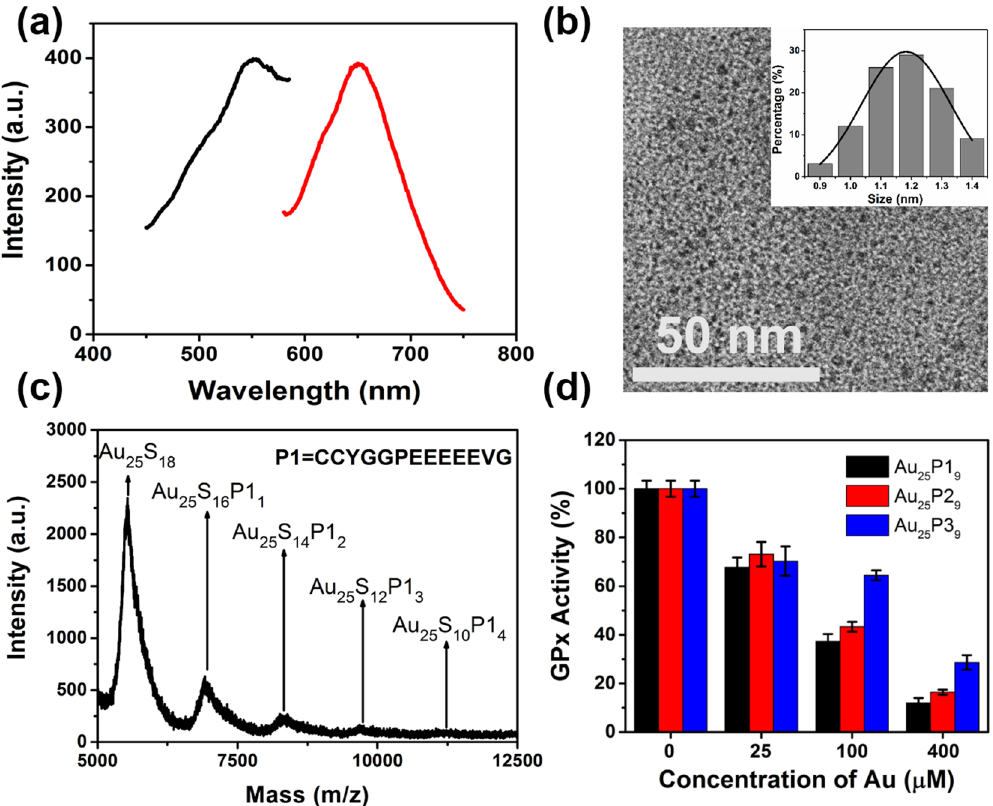
Figure 2. ( a ) Fluorescence excitation (black line) and emission (red line) spectra of Au 25 P1 9 . ( b ) HRTEM images of Au 25 P1 9 . Inset shows diameter distribution from statistic results of 100 particles. ( c ) MALDI-TOF MS spectra of Au 25 P1 9 . ( d ) GPx-1 activity suppressed by peptide-Au clusters in a dose dependent manner in